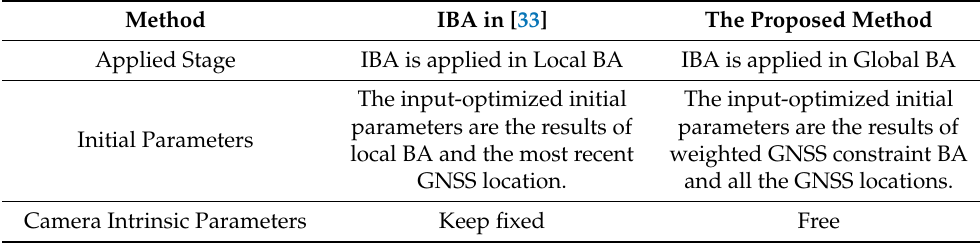
Table 2. The differences between the IBA used in [33] and the proposed